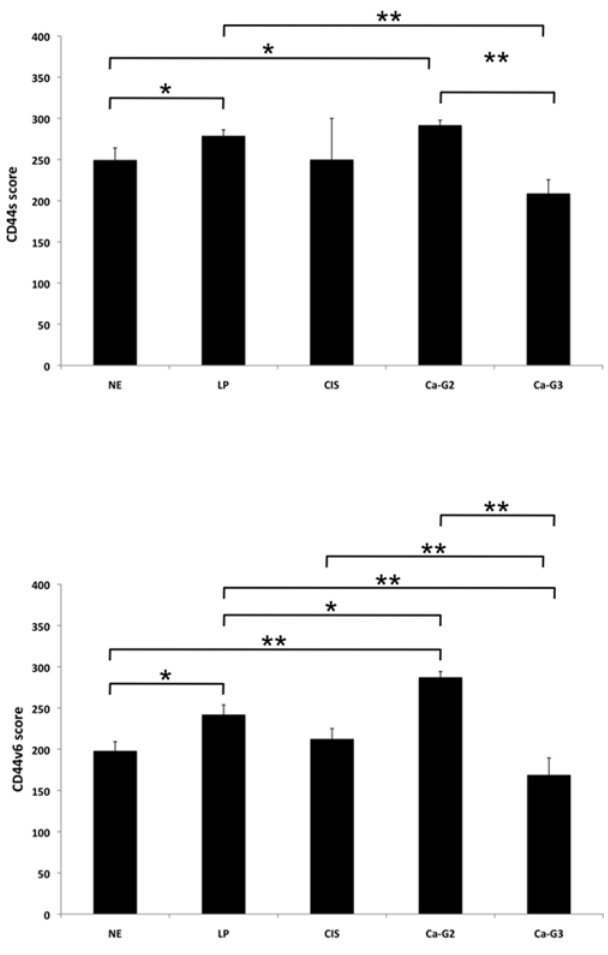
Figure 3. CD44s and CD44v6 expression scores in head and neck epithelia. The expression scores of CD44s ( upper ) and CD44v6 ( lower ) implement expression intensity and percentages of positive cells (score=staining intensity 6 % positive cells; max score 300). Shown are the mean scores with standard deviations. Where indicated, differences across specimen groups were significant (* p , 0.05; ** p , 0.005). NE : normal epithelium; LP : leukoplakia; CIS : carcinoma in situ ; Ca-G2 : grade 2 carcinoma; Ca-G3 : grade 3 carcinoma.